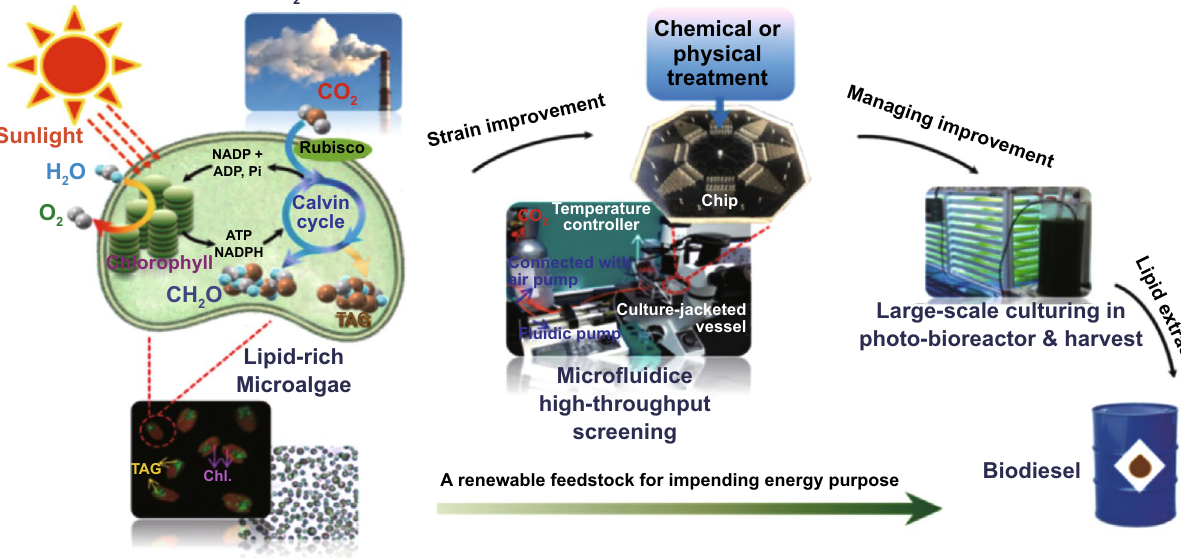
Fig. 10 Schematic illustration of all steps of the microalgae-based biofuel production pipeline and how the developed GNT-Microfluidic che- mostatic bioreactor system work. Algal cell structure serves goals of biodiesel production through the photosynthetic carbon fixation pathways the Calvin-Benson